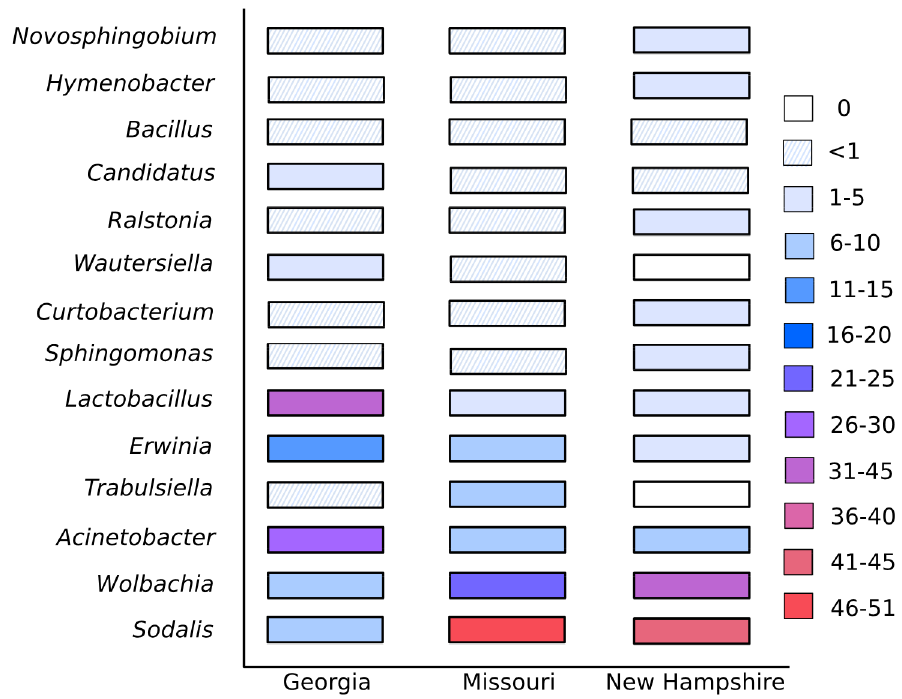
Figure 3. The percentage of 16S reads found across the top 14 bacterial genera in brood provisions from each site. Many bacteria were common to all sites but the relative abundance of the most common bacteria varied broadly.